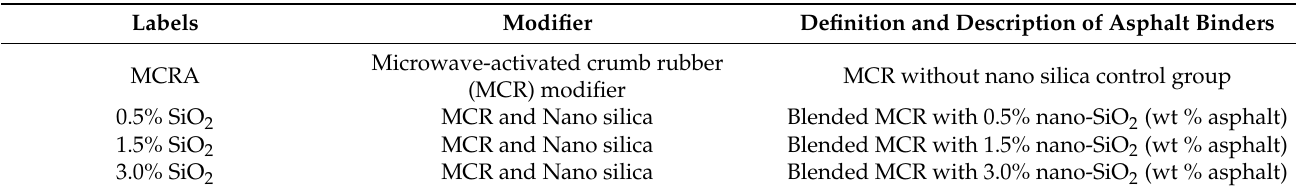
Figure 3. Experimental flow chart utilized herein.